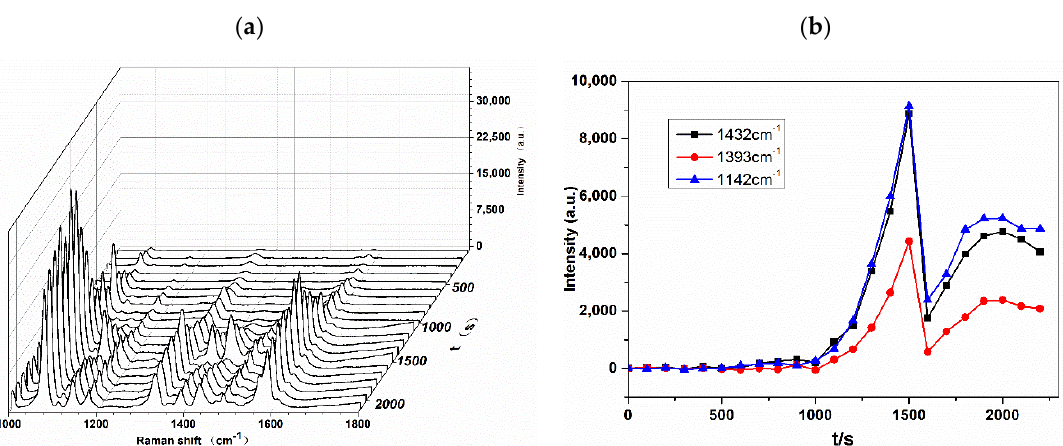
Figure 7. ( a ) Map of dynamic SERS (D-SERS) spectra of azo dye derived from Tyr (10 − 6 M) from 0 s to Figure 7. (a) Map of dynamic SERS (D-SERS) spectra of azo dye derived from Tyr (10 −6 M) from 0 s to